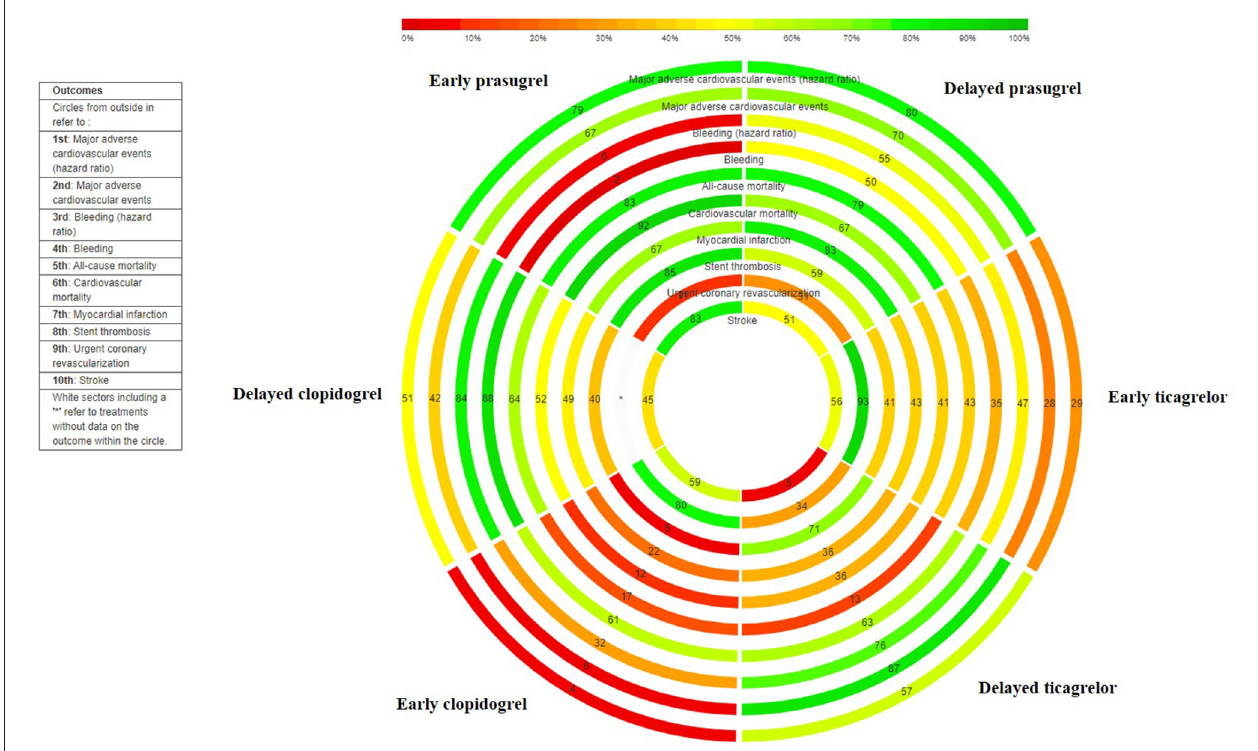
FIGURE 2 | Rank-heat plot. Each concentric circle represents a different outcome (as labeled), with the outermost circle representing the MACEs, and the innermost circle representing stroke. The scale bar represents the ranking statistic for each intervention using the p -scores, where 0% (red) indicates the lowest possible rank (worst treatment), and 100% (green) represents the highest possible rank (best treatment). Each rectangle represents an intervention and is coded using a letter outside the outmost circle (see treatment legend). The number within each rectangle represents the ranking statistic of the intervention for the particular outcome circle.